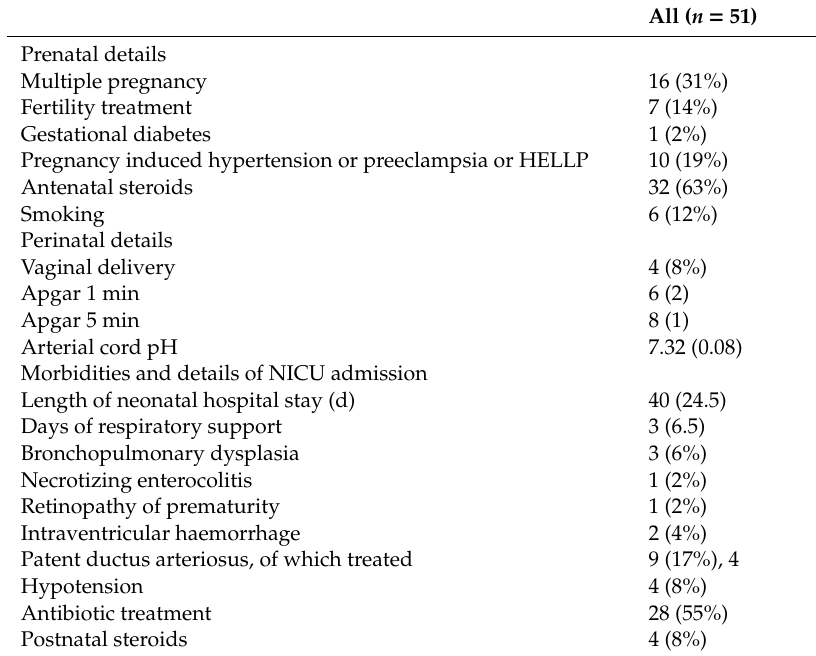
Table 2. Details of pre-, peri-, and postnatal morbidities and treatments for the study participants born